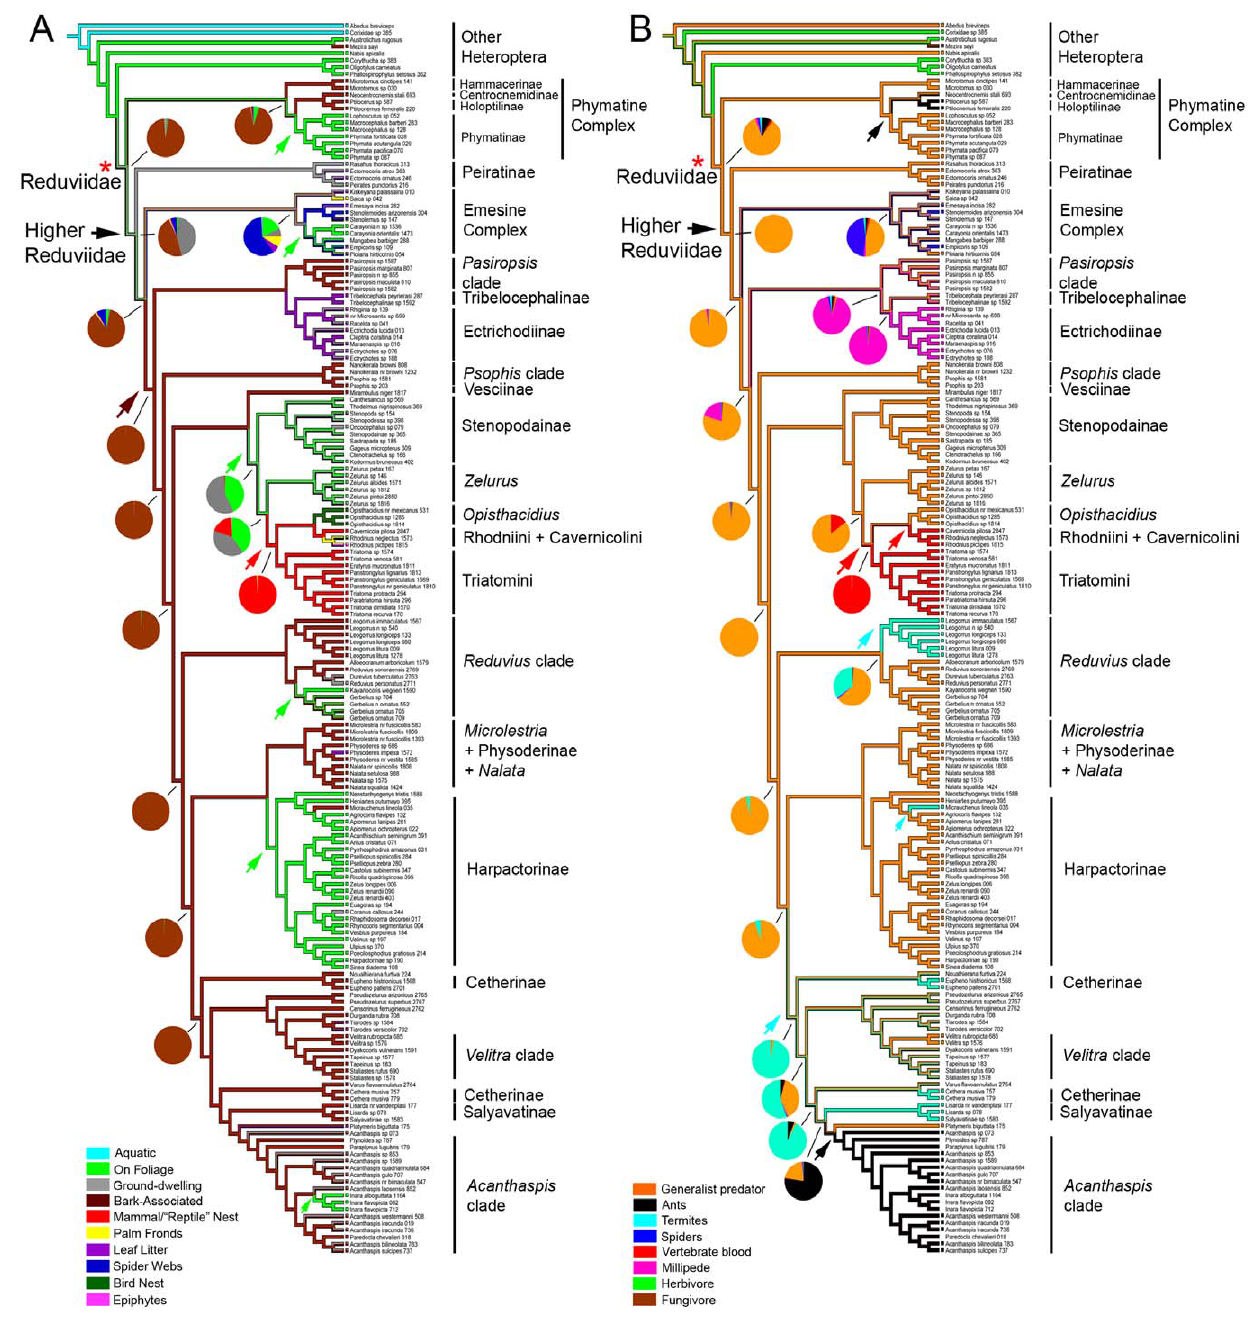
Figure 3. Ancestral state reconstructions based on best maximum likelihood tree. A. Microhabitats. Microhabitats of terminal taxa mapped onto ML best tree using Mesquite parsimony (P) model and maximum likelihood (ML) model in BayesTraits. Branches are color coded to represent different microhabitats (see color legends) based on parsimony and similarly-colored pie-charts represent probabilities generated from BayesTraits. Terminals without colored squares indicate unknown microhabitats and are coded as missing information in the matrix. Bark-associated lifestyle (brown arrowhead) is ancestral for all Higher Reduviidae except Peiratinae and Emesinae under both P and ML. Foliage-living (green arrowheads) has evolved at least six times independently within Reduviidae. Ancestral condition for all reduviids (red asterisk) remains ambiguous (bark associated/ground-dwelling/foliage-living) under P but ML favors bark-association (96.39%). Ancestral condition for Triatominae + Opisthacidius is mammal/‘‘reptile’’ nest dwelling (red arrowhead). B. Prey Specialization. Prey specialization of terminal taxa mapped onto ML best tree using Mesquite parsimony (P) model and maximum likelihood (ML) model in BayesTraits. Branches and pie-charts (from ML) are color coded to represent different targeted prey (see color legends). Terminals without colored squares indicate unknown diets and are coded as missing information in the matrix. Ancestral condition for all reduviids is generalist predator (red asterisk). Hematophagy (red arrowheads) may have evolved once or twice independently under P while ML favors a single evolution (99.62%). Termite-specialization (cyan arrowheads) occurred at least three times independently while ant-specialization (black slanted arrowheads) evolved at least twice (Holoptilinae, Acanthaspis clade).